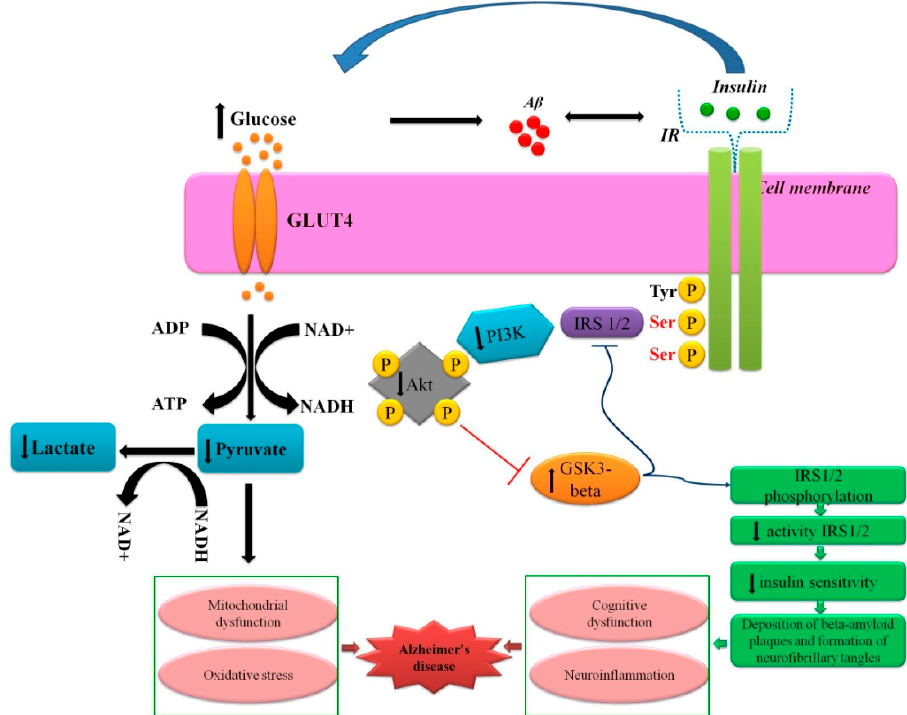
Figure 1. Insulin signaling in the brain in Alzheimer’s disease. Accumulation of A β disrupts the binding of insulin to insulin receptors on brain cells leading to aberrant IRS1/PI3K signaling, especially at the level of IRS1. It decreases PI3K/Akt activity and increases GSK-3beta kinase activity, which promotes phosphorylation of tau protein and increased deposition of A β -consisting plaques as two key hallmarks of Alzheimer’s disease. Reduced uptake of glucose through GluT transporters and intracellular hypometabolism of glucose in the brain cells (diminished glycolysis and OXPHOS) caused by insulin resistance are associated with the development of mitochondrial dysfunction, ROS overproduction, and oxidative damage of biomacromolecules.